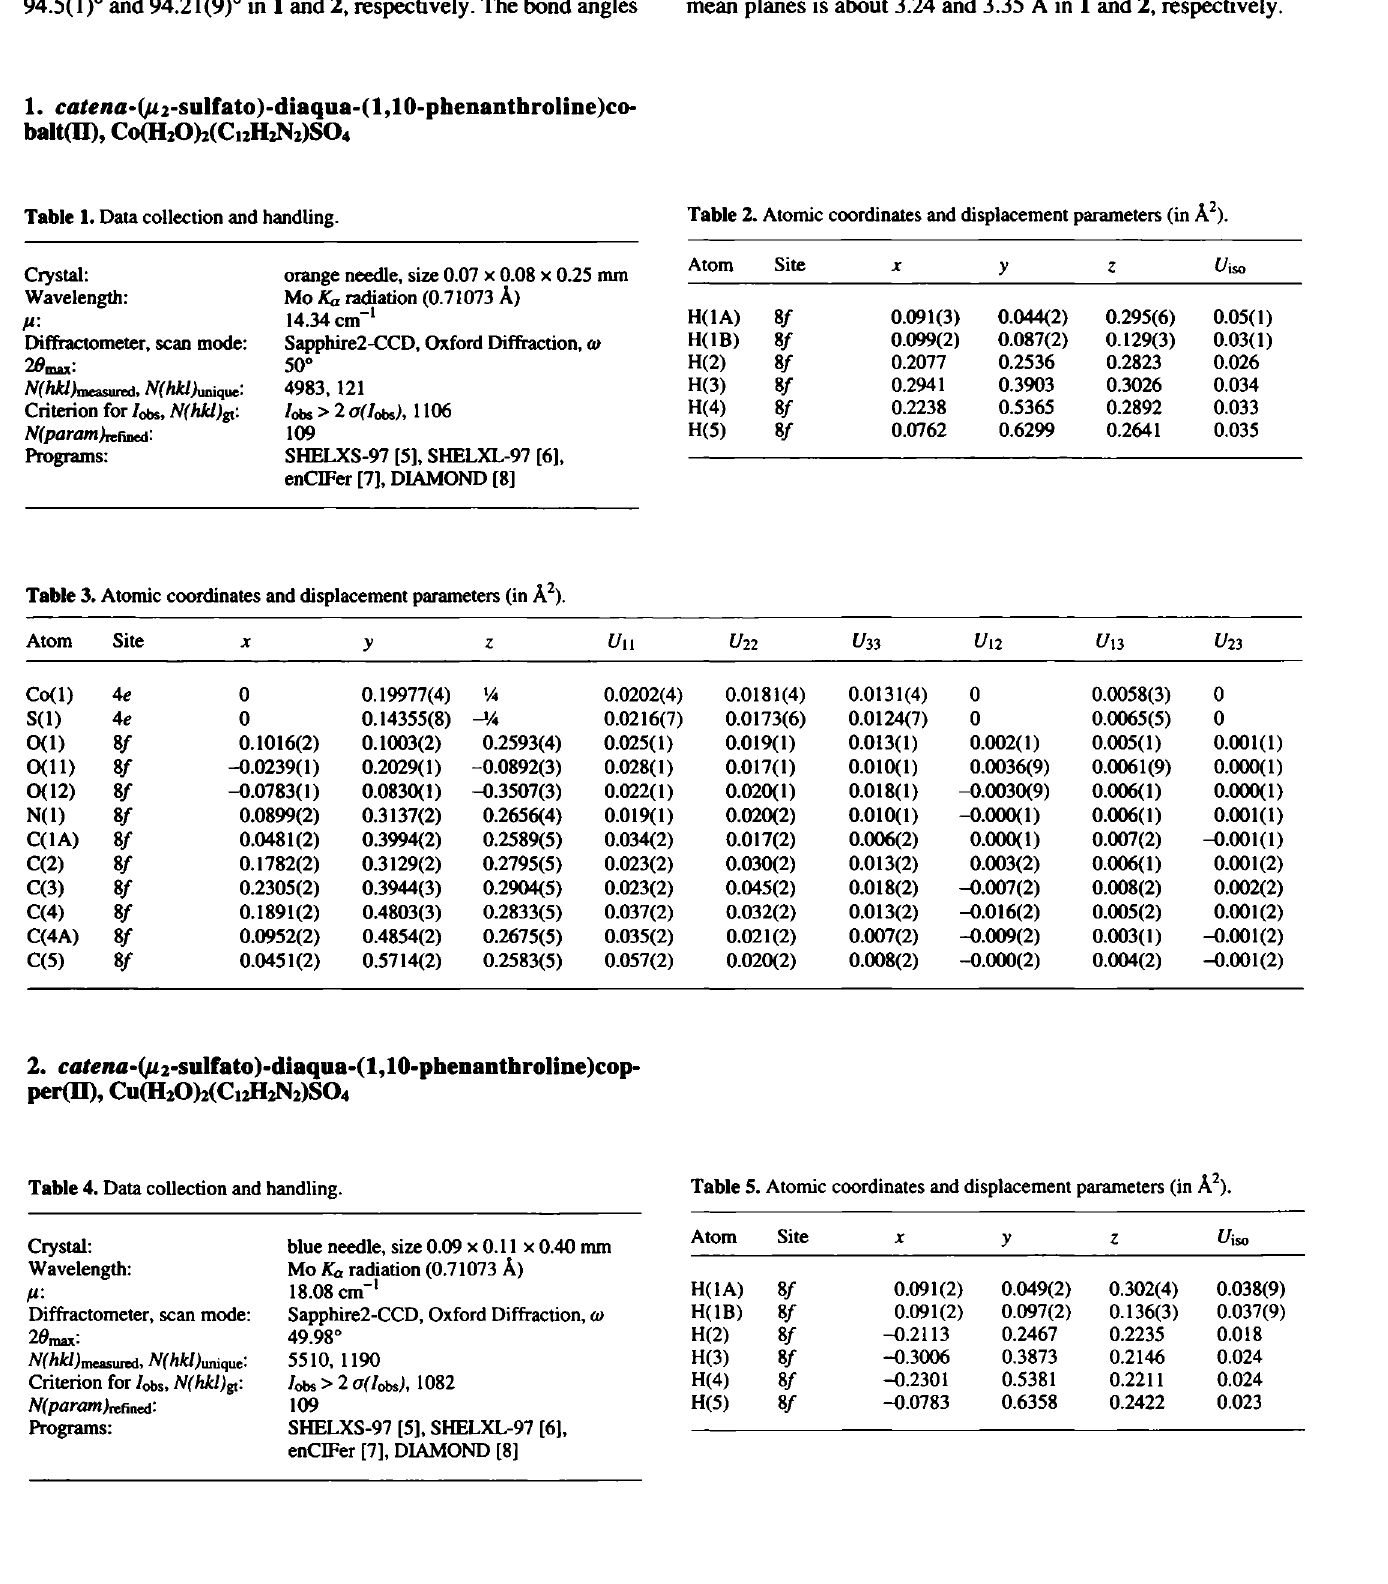
Table 1. Data collection and handling. Table 2. Atomic coordinates and displacement parameters (in Â 2 ).